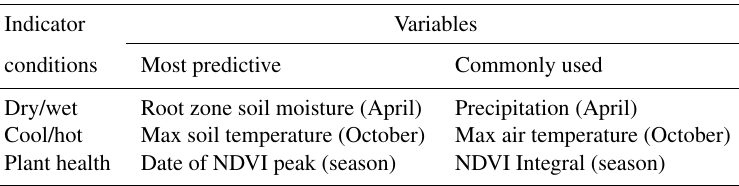
Table 3. List of the six drought impact indicators used in the crop losses analysis, where three are the most predictive variables (identified by the predictor importance analysis) and three are, respectively, commonly used